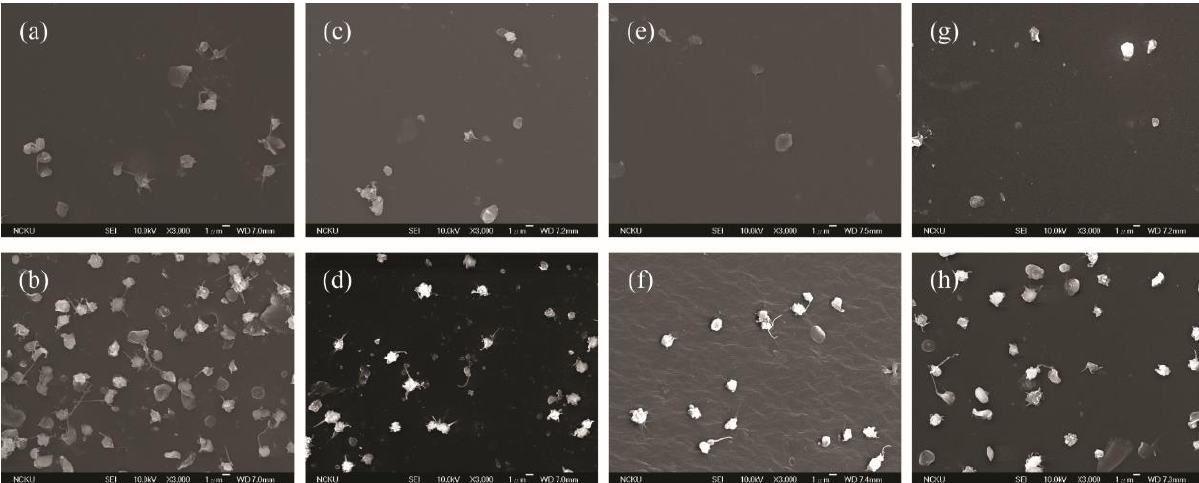
Figure 6. Cytotoxicity assay on different sulfonated copolymers by ( a ) the extracts and ( b ) direct contact.